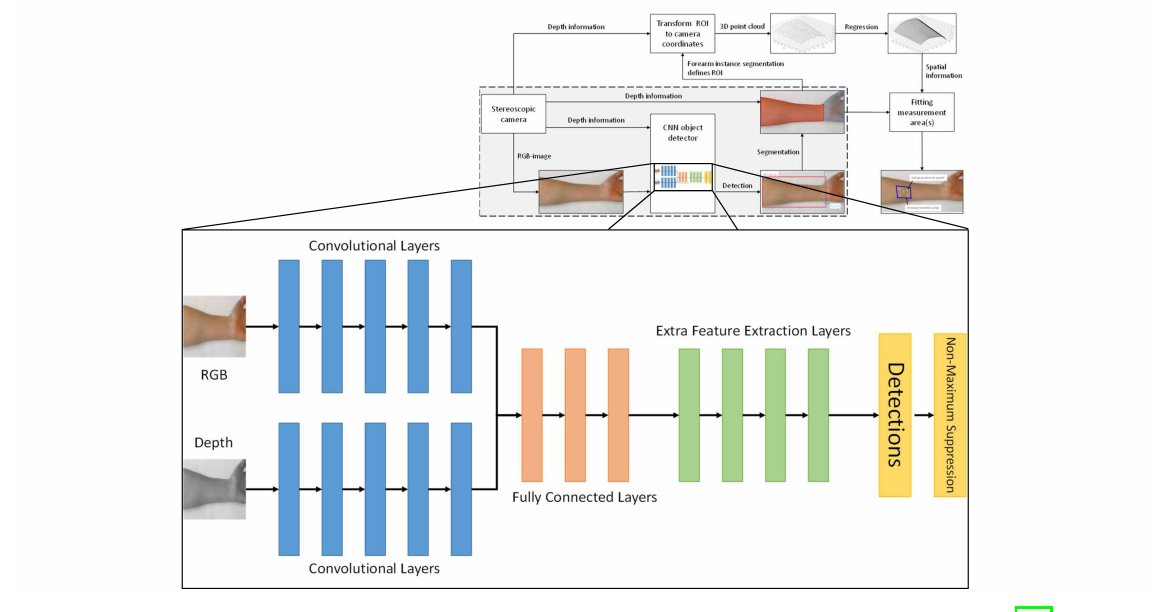
Figure 3. Network Overview of SSD with RGB-D Architecture derived from